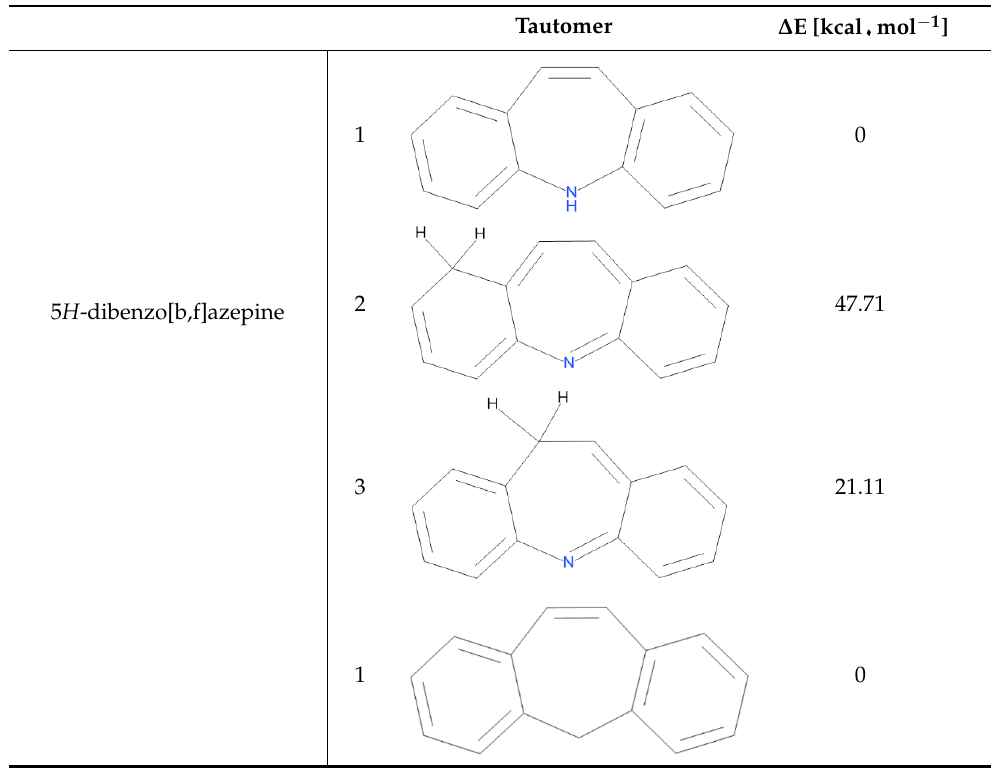
Table 1. Relative energies ( Δ E in kcal × mol ‐ 1 ) for 5 H ‐ dibenzo[b,f]azepine and 5 H ‐ dibenzo[a,d][7]annulene isomers.